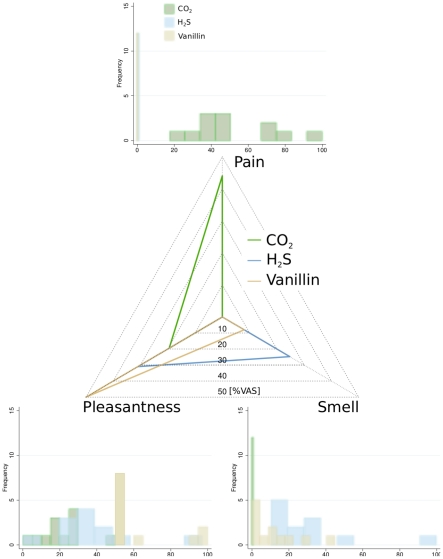
Estimates of the CO2, H2S and vanillin stimuli with respect to pain, smell or pleasantness, rated by means of a visual analog scale displayed at 3.4–6.6 s after stimulus presentation and ranging from “no pain” to “pain experienced at maximum” or “no odour” to “intensive odour” or “unpleasant” to “very pleasant”.CO2 was always painful and never smelled. H2S or vanillin stimuli were never painful but smelled.